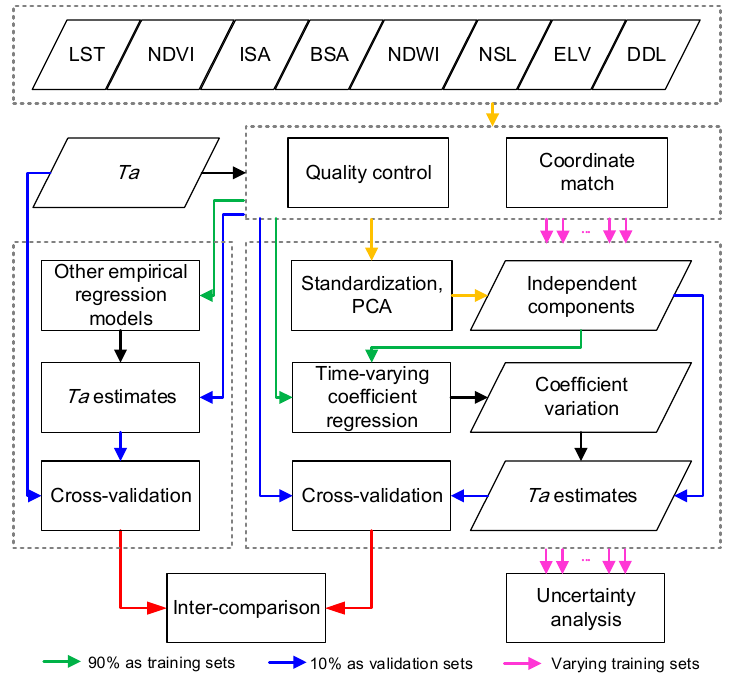
Figure 3. Flowchart of methods.